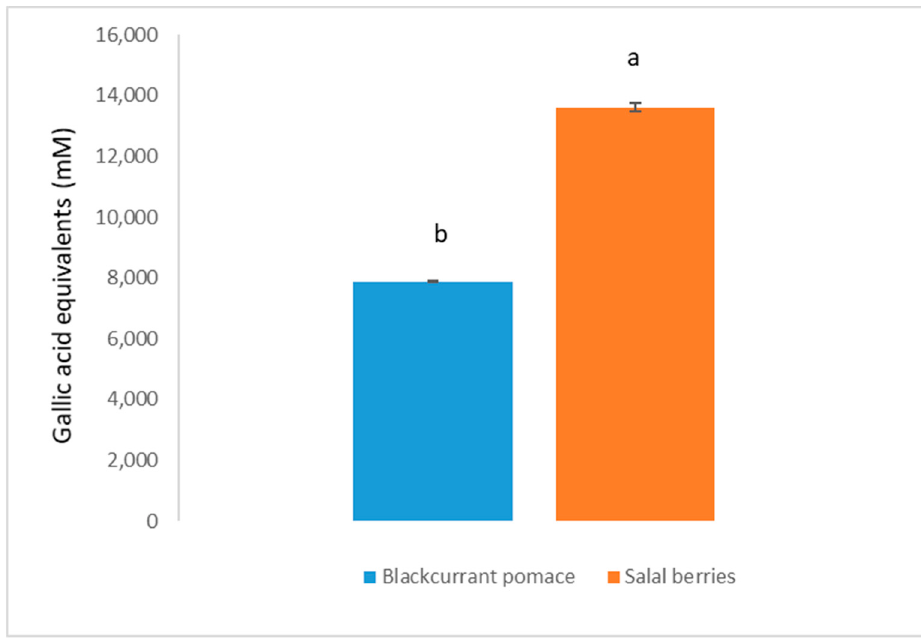
Figure 2. Total phenol content of dried fruit powders (DFP). Results are presented as means ± SD. Different low case letters denote significant differences ( p < 0.05). Beverages 2018 , 4 , x FOR PEER REVIEW